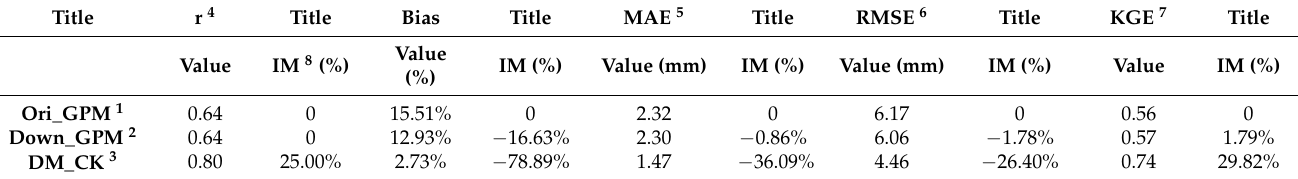
Table 2. Evaluation for quantitative indices of the Ori_GPM, Down_GPM, and DM_CK for daily precipitation estimates from March 2016 to February